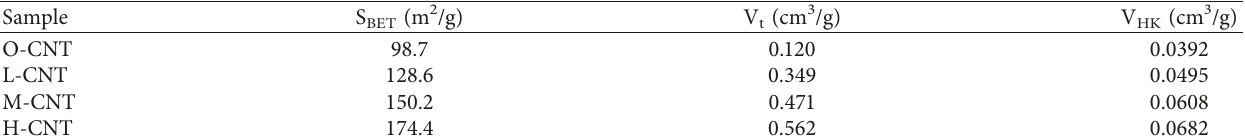
Table 1: Textural characteristics obtained by N